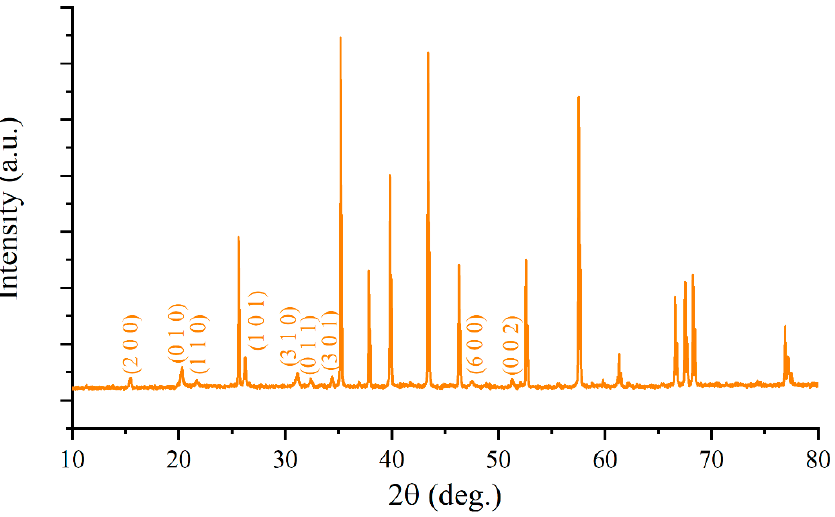
Figure 4. Diffractogram for V 2 O 5 film on Pt/Al 2 O 3 /Pt chip.